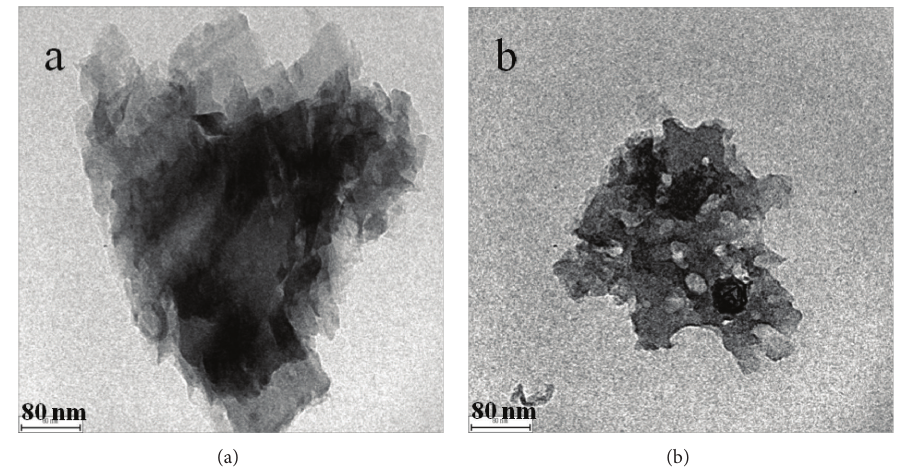
Figure 4: TEM images of the g-Fe-C 3 N 4 and m-Fe-C 3 N 4 samples.